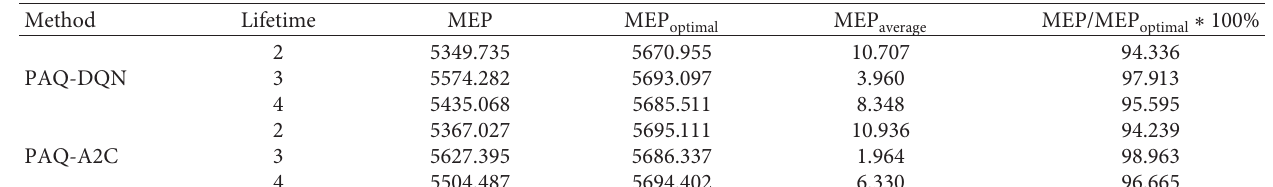
Table 13: MEP for proposed algorithm and optimal policy.